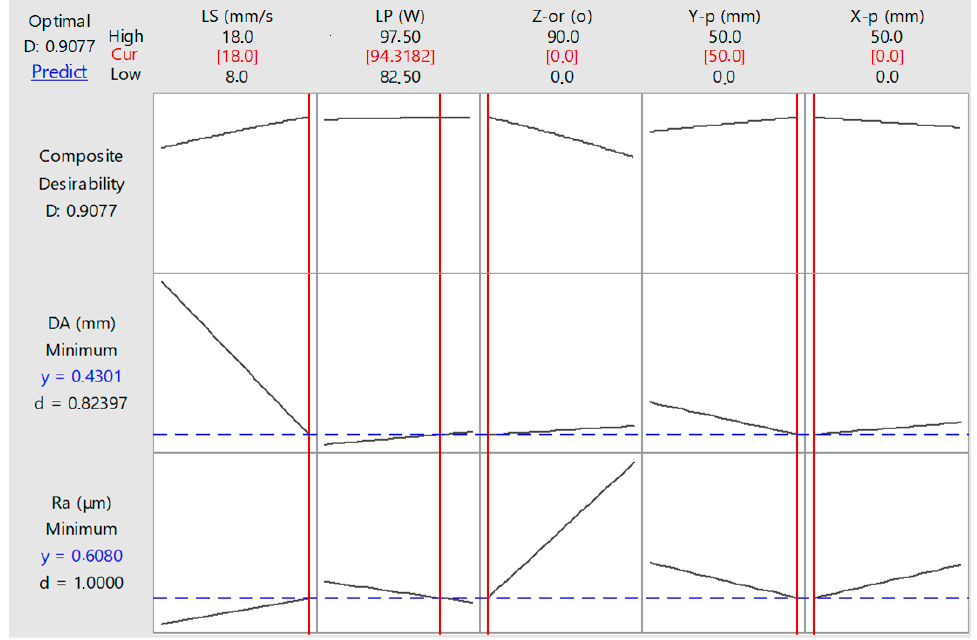
Figure 7. Multi-parameter multi-objective optimisation plot.